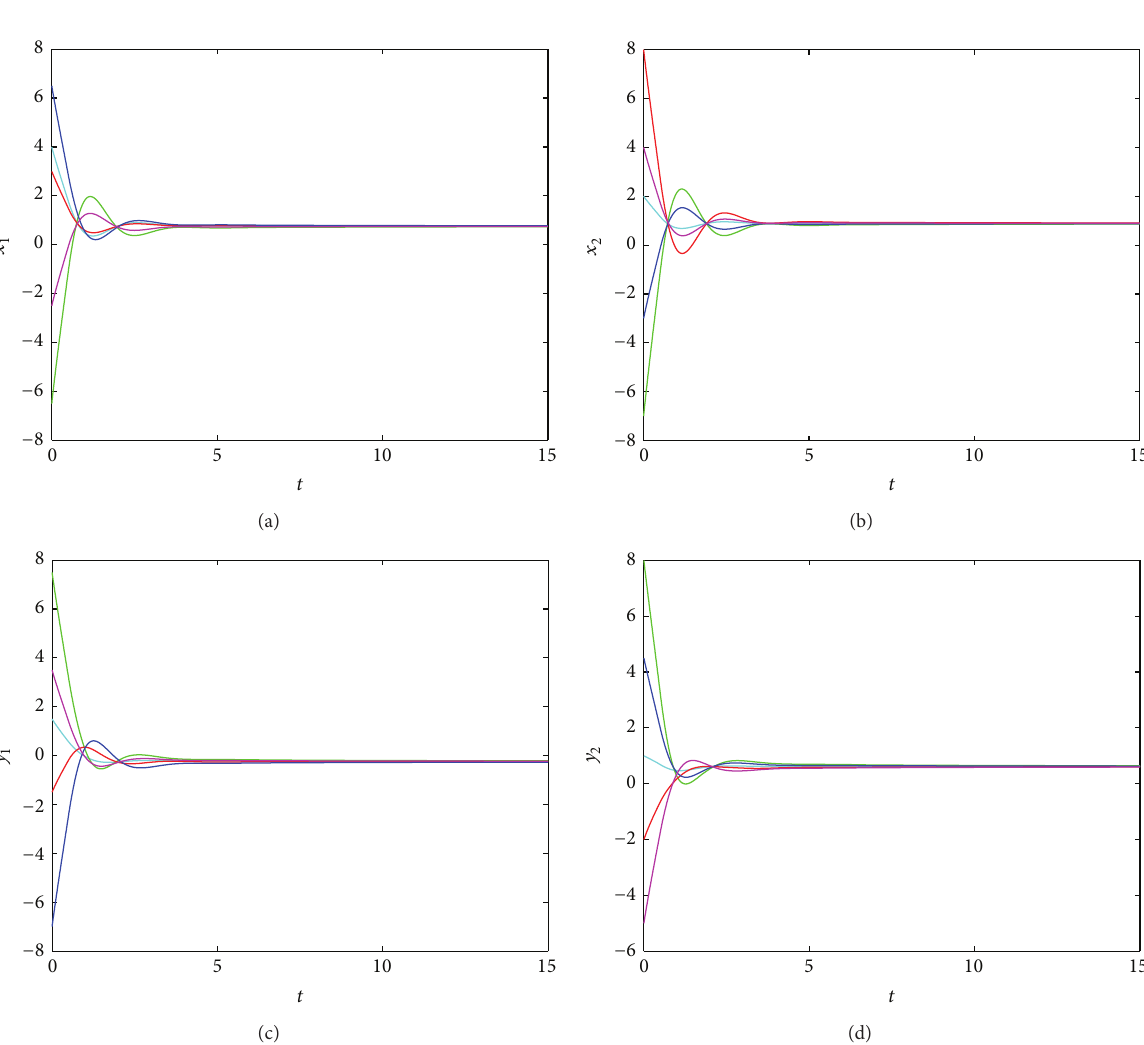
Figure 5: Transient states of the fractional-order BAM neural networks in Example 3 with 𝛼 = 0.95 , 𝜎 = 0.50 , and 𝜏 = 0.50